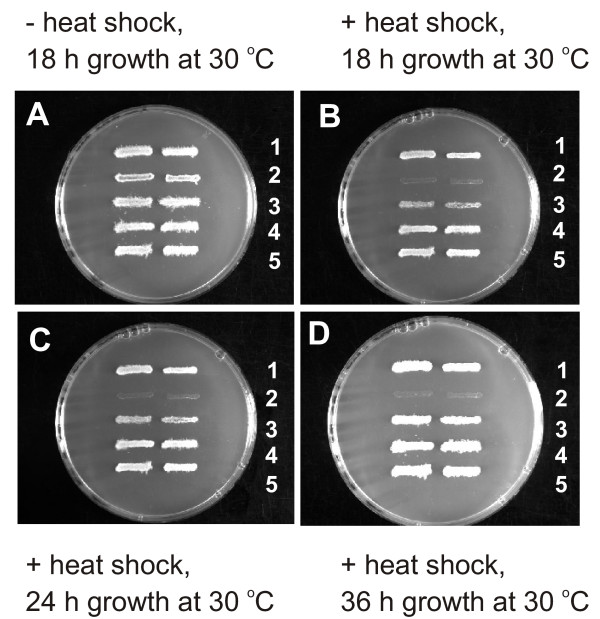
Complementation of the PDE-deficient S. cerevisiae strain PP5. Panel A: plate without heat-shock treatment, incubated at 30°C for 18 h; panels B – D: plates heat-shocked for 15 min at 55°C, and subsequently incubated at 30°C for 18 h (panel B), 24 h (panel C) or 36 h (panel D). The plates always display rows of patches of two independent transformants transfected with the following plasmids: Row 1: pLT1 + TbrPDEA (= positive control); row 2: pLT1, empty plasmid (= negative control); row 3: pLT1 + LmjPDEA; row 4: pLT1 + LmjPDEB2; row 5: pLT1 + LmjPDEB1.